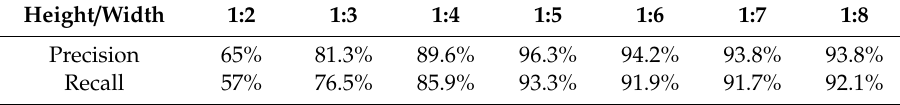
Table 5. Di ff erent height / width threshold settings. The maximum values are marked in bold. Table 5. Different height/width threshold settings. The maximum values are marked in bold.